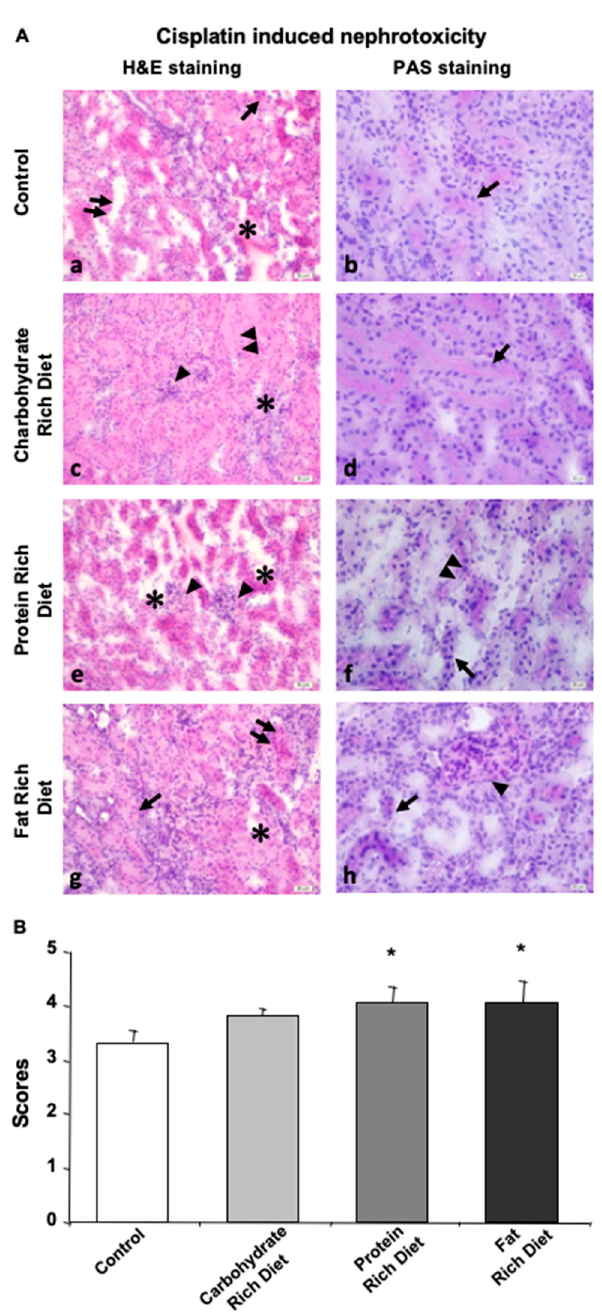
Figure 4. Dietary content determines the extend of CP-induced nephrotoxicity. Tissue of null diet kidney. ( A ) Microphotographs of H&E and PAS staining. ( a , b ) Kidney tissue of control group was shown. ( a ) Damage of tubular shape and loss of epithelial cells lining inner part of tubule (doble arrow), gaps in between the tubules (*) and inflammation (arrow), and ( b ) intact basal membrane (arrow) were demonstrated. ( c , d ) Kidney tissue of carbohydrate group was shown. ( c ) Dysmorphic tubules and cell loss (double arrowhead), hypertrophic glomeruli (arrowhead) and small gaps in intertubular space (*), and ( d ) basal membrane (arrow) were demonstrated. ( e , f ) Kidney tissue of protein group was shown. ( e ) Large separations and destructions in between the tubules (*) and loss of morphology (arrowhead) and ( f ) microvilli loss at the apical surfaces of the tubules (double arrowhead) and destruction of tubular basal membrane morphology (arrow). ( g , h ) Kidney tissue of fat group was shown. ( g ) Morphological disturbances and epithelial cell loss (arrow), gaps (*) and inflammation (double arrow) in between neighboring tubules and ( h ) basal membrane loss around the tubules (arrow) and glomerular dilatation (arrowhead) were demonstrated. ( a , c , e , g ) H&E dye,